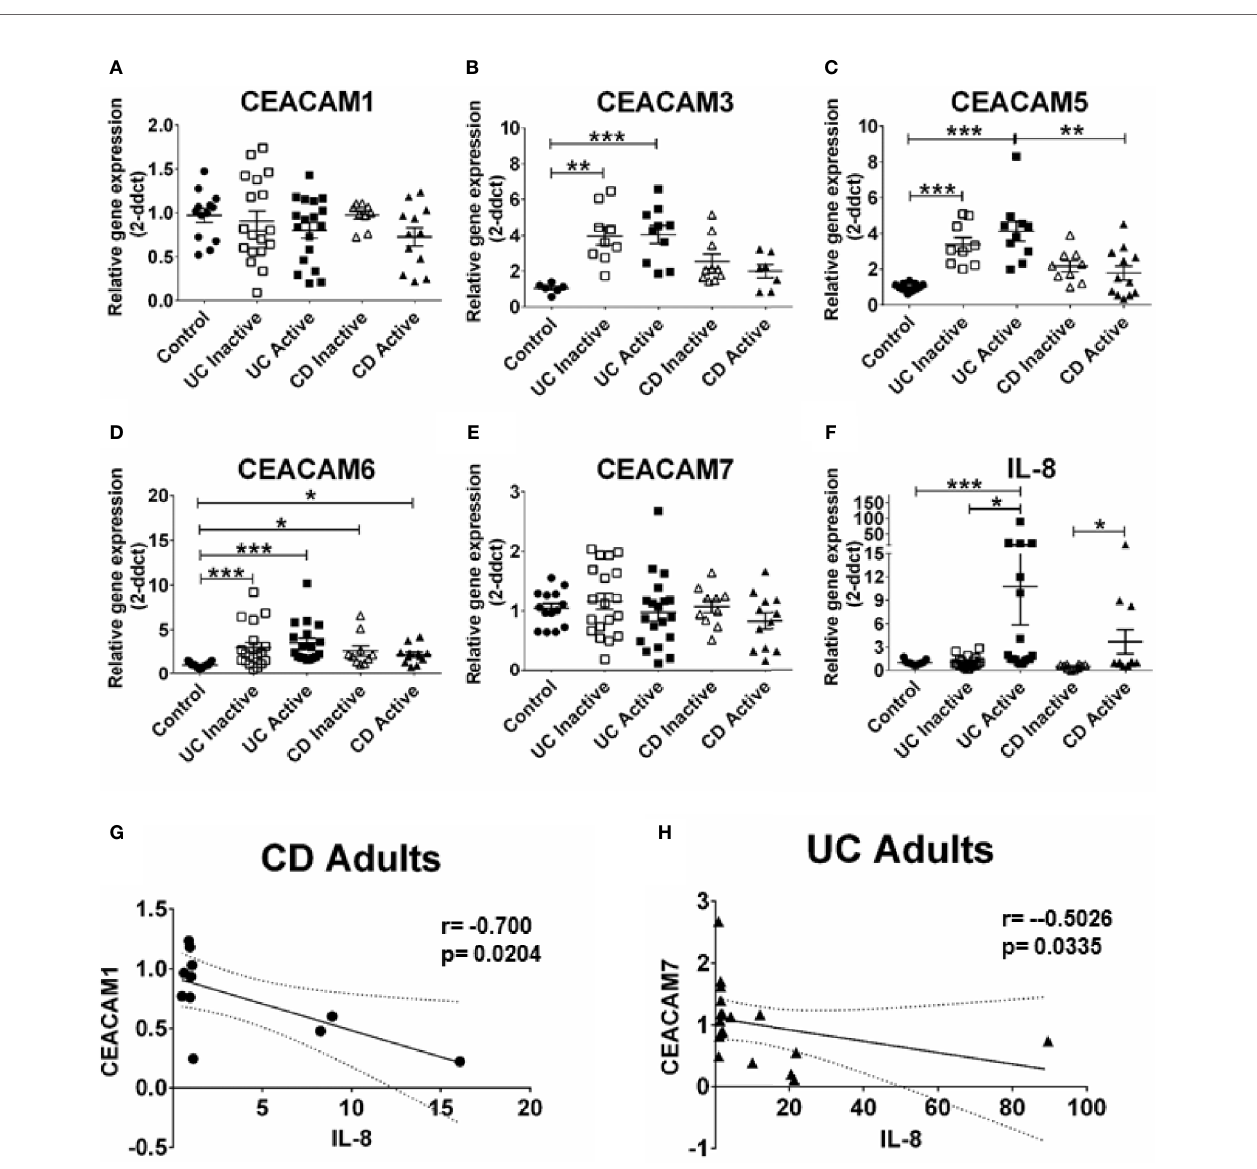
FIGURE 2 | CEACAMs gene expression in adult colonic mucosa of patients with Ulcerative colitis (UC) and Crohn ’ s disease (CD) with active and inactive disease and controls. Gene expression of (A) CEACAM1, (B) CEACAM3, (C) CEACAM5, (D) CEACAM6, (E) CEACAM7, (F) IL-8 as determined by RT q-PCR. (G) Spearman correlation on relative mRNA levels between IL-8 and CEACAM1 in adult CD Active samples and of (H) IL-8 and CEACAM7 in adult colonic UC. n=10 – 18, active Ulcerative Colitis (UC); n=10 – 19, inactive UC; n=7 – 11 active Crohn ’ s Disease (CD); n=10 inactive Crohn ’ s Disease and n=6 – 14 controls. An ANOVA test with post- hoc analysis was used to analyze gene expression data and Spearman correlation test. *P < 0.05, **P < 0.01, ***P <